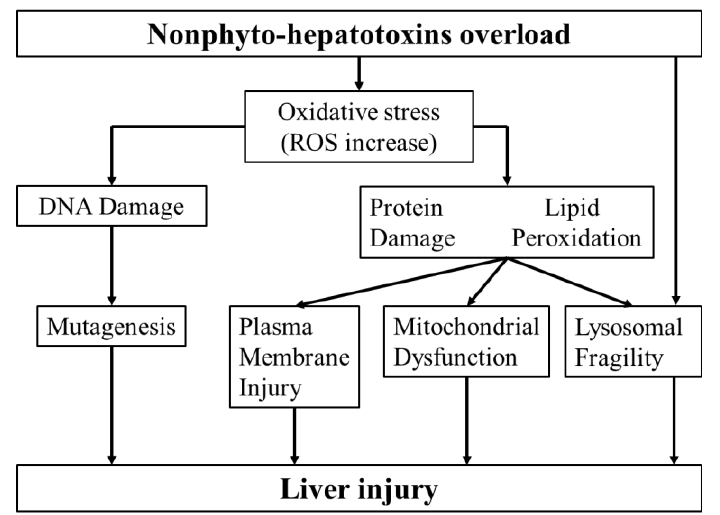
Figure 5 . Summarized hypothetical mechanisms of liver injury induced by nonphyto-hepatotoxins overload. Modified from a report published by Britton [115]. overload. Modified from a report published by Britton